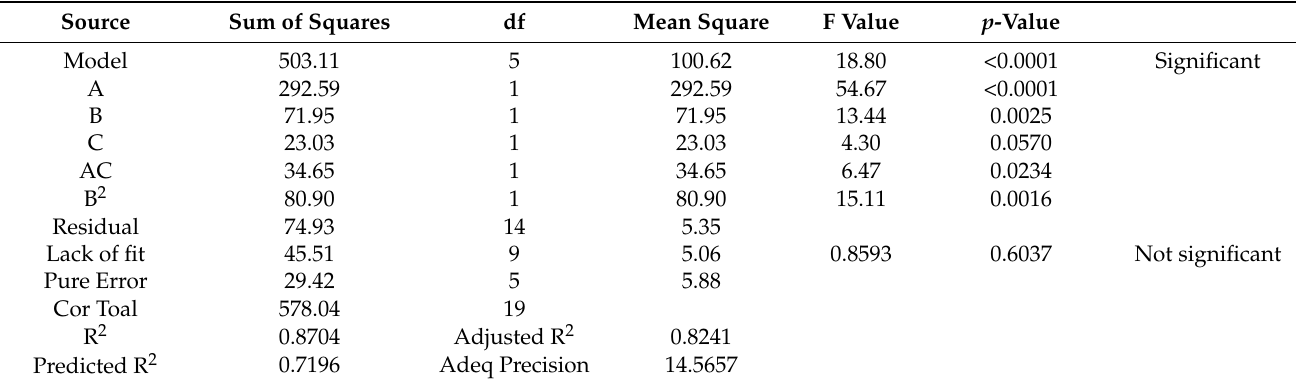
Table 4. ANOVA table for bead height.